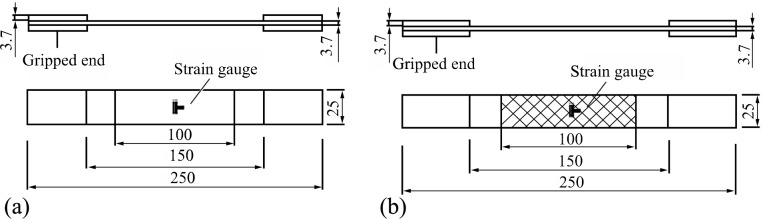
Specimens for the GFRP tests.(a) Specimen size for the tensile tests of the face sheets and webs. (b) Specimen size for the longitudinal and transverse shearing tests of the webs.